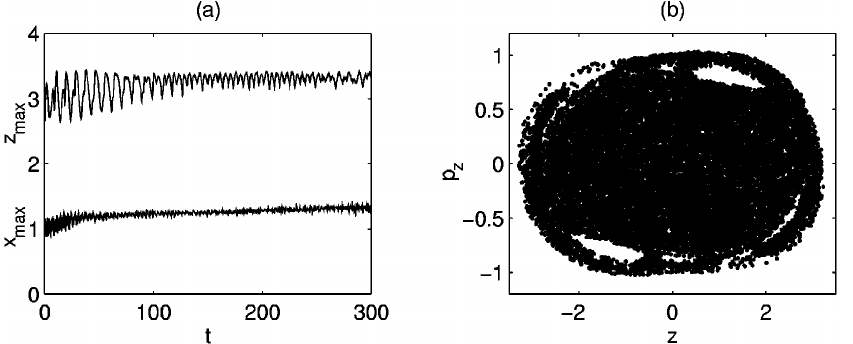
FIG. 6. 6D uniform distribution with initial zero mismatch ( (cid:99) (cid:121) (cid:97) (cid:173) (cid:51)(cid:44) h (cid:120) (cid:173) (cid:48)(cid:46)(cid:55)(cid:53)(cid:44) h (cid:122) (cid:173) (cid:48)(cid:46)(cid:54)(cid:53) ): (a) maximum (cid:120) and (cid:122) and (b) (cid:122) (cid:45) (cid:112) (cid:122) diagram with the low-density cut.